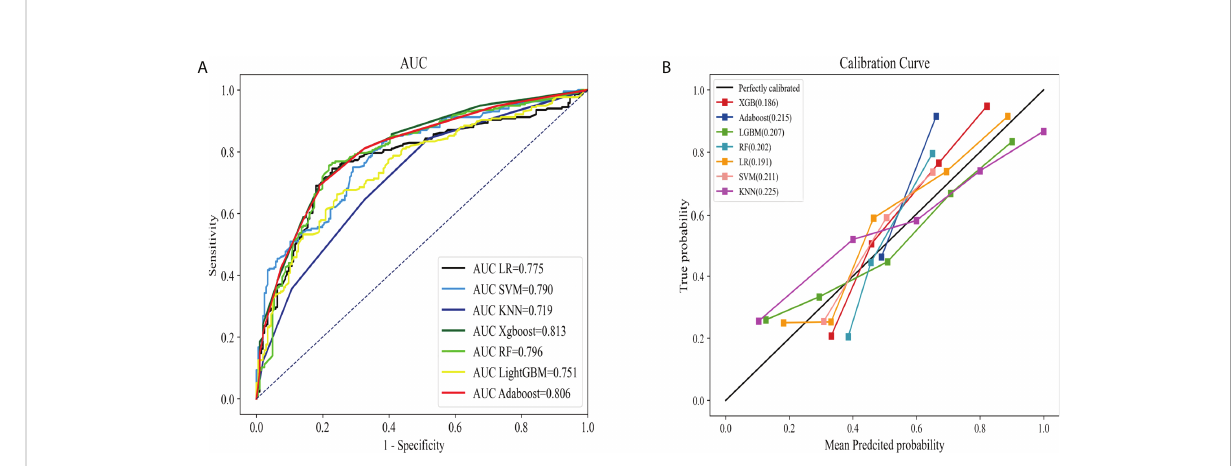
FIGURE 2 The perfomance comparison of different machine learning models in predicting lyph node metastasis. The receiver operating characteristic curves (A) and calibration curves (B) of different